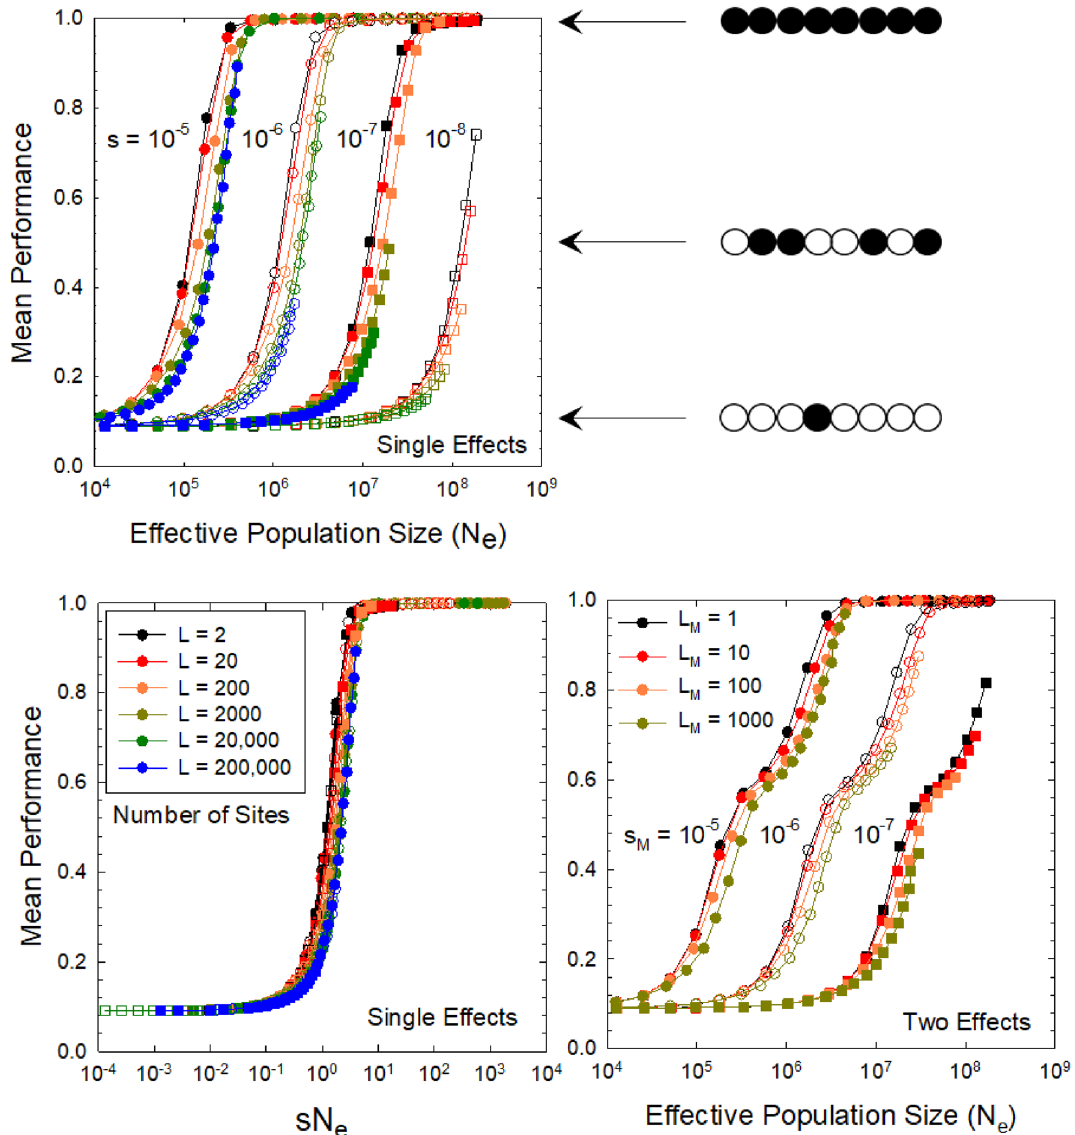
Figure 2. Mean performance (on a 0 to 1 scale) as a function of the effective population size ( N e ), the selection coefficient ( s ), and the size of linkage groups, for the case of a biallelic model with the mutation rate to the beneficial allele being 10 the reciprocal rate. All results denote the selection-drift-mutation equilibrium × performance (as described in the main text, but equal to the mean frequency of alleles for the case of single + effects). (Upper left) Results are given for the situation in which all sites have equal mutational effects, for four values of the selection coefficient s (bundles of curves) and six linkage-block sizes [color coded as in the inset of the lower left panel]. The cartoons to the right denote arbitrary stretches of linked sites with different fractions of sites containing alleles (solid balls), increasing as mean performance increases. As s declines by a factor x , the + curves shift to the right in an essentially constant pattern, such that a specific level of performance requires an x -fold increase in N e . (Lower left) The latter point is made by plotting the points in the upper left panel against the product N e s , which leads to nearly perfectly overlapping curves. (Lower right) Results for the situation in which two types of linked sites are simultaneously selected upon: the numbers and selection coefficients associated with large-effect sites are given within the graph, whereas the small-effect sites are 10 more × abundant but have 10 smaller selective effects, such the full performance of the system is equally distributed × over the linked sets of large- and small-effect